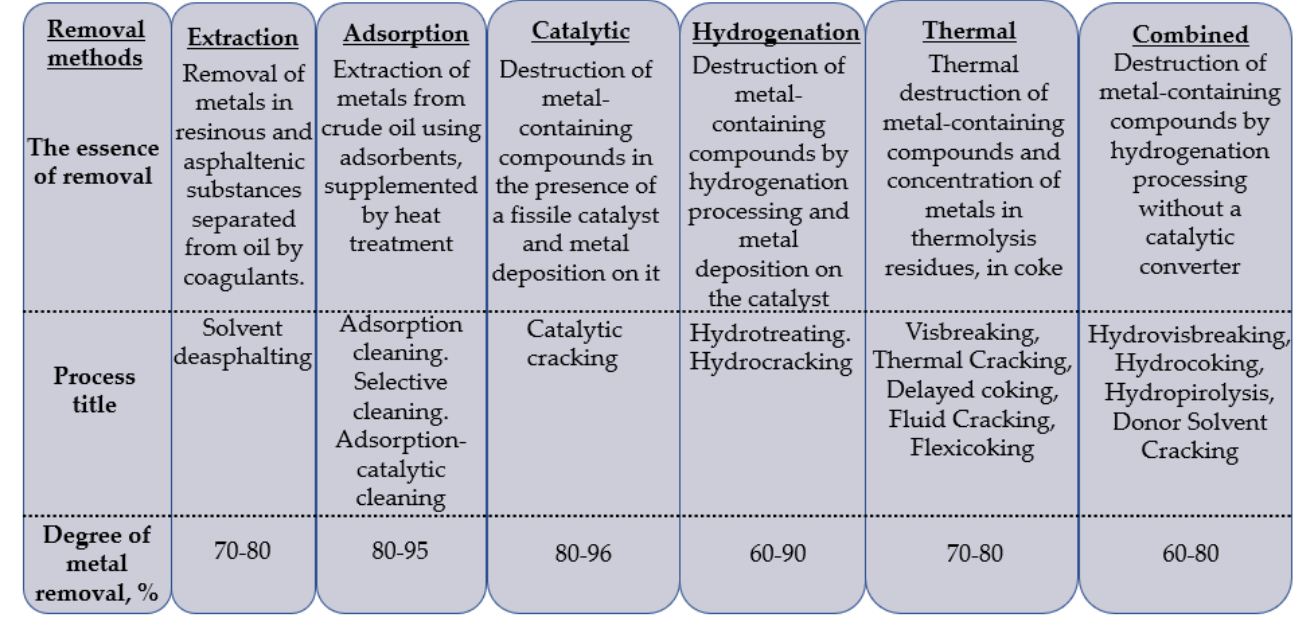
Figure 1. Classification of the main processes of destructive processing of heavy oils and residues.